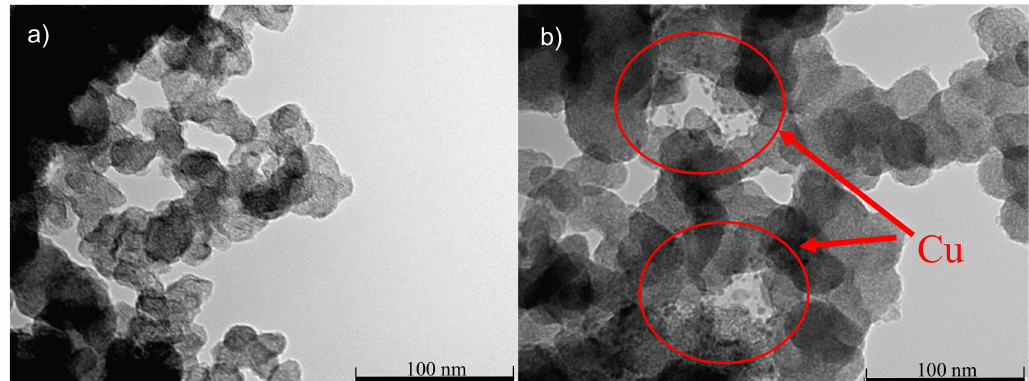
Figure 2. TEM images for ( a ) bare carbon black and ( b ) Cu-deposited carbon